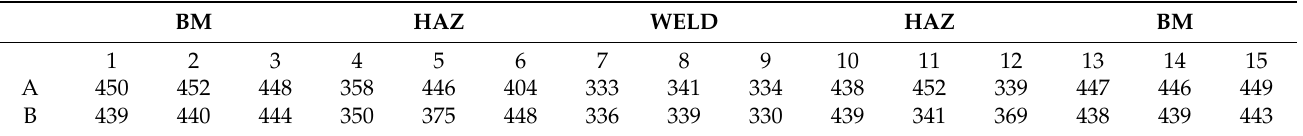
Figure 6. Hardness distribution in the tested welded joint—average result. Table 4. Average hardness test results.